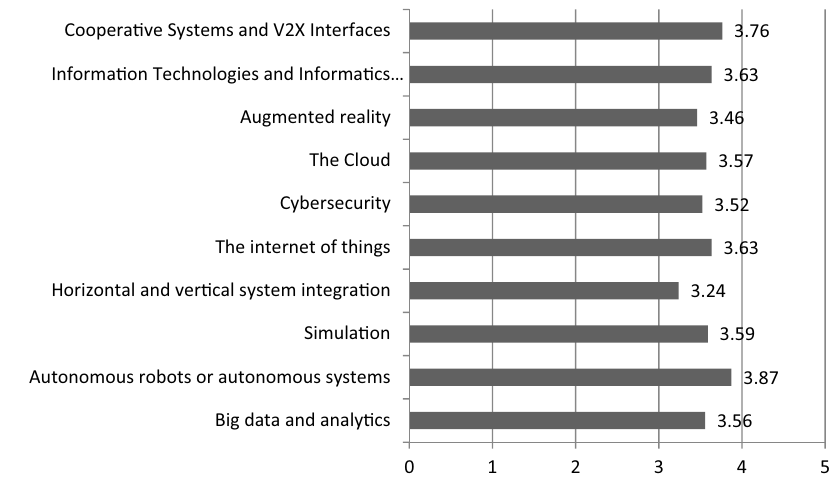
Figure 2: Technical competences, overall results. Source: author ’ s own